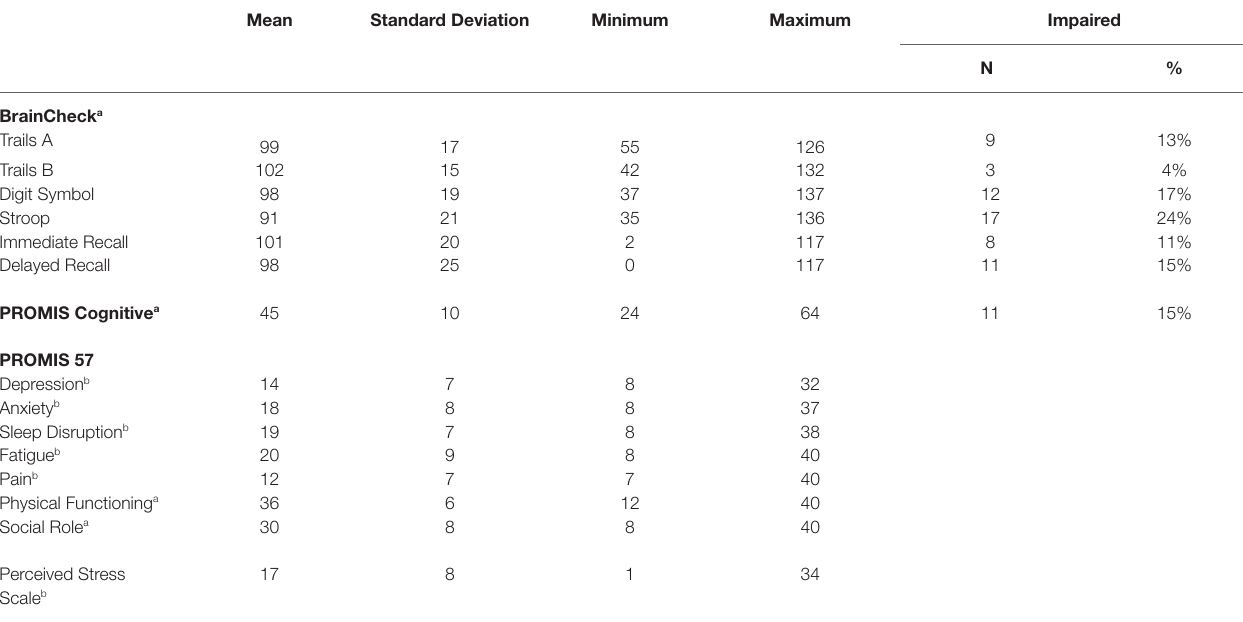
TABLE 2 | Cognitive-behavioral outcomes ( N =